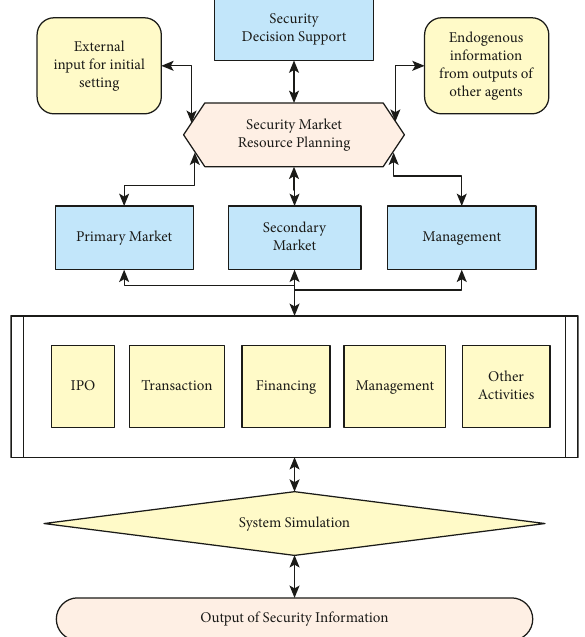
Figure 6: Overview of the process and structure of securities system (source: Guangzhou Milestone Software Co., Ltd.,